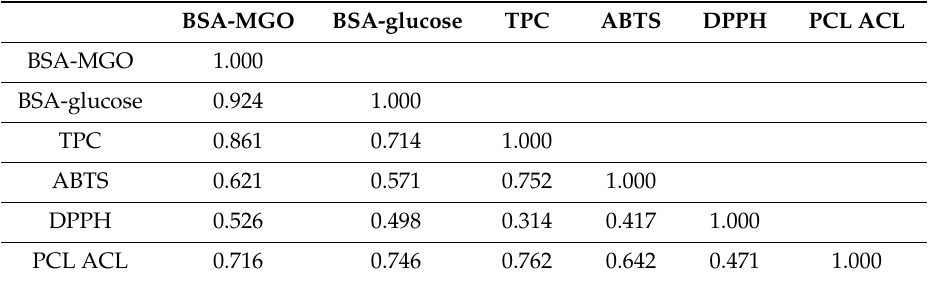
Table2. Pearson’scorrelationcoe ffi cientbetweenBSA-MGO,BSA-glucose, andTPC,andtheantioxidant activity (ABTS, DPPH and PCL) of spices. BSA-MGO BSA-glucose